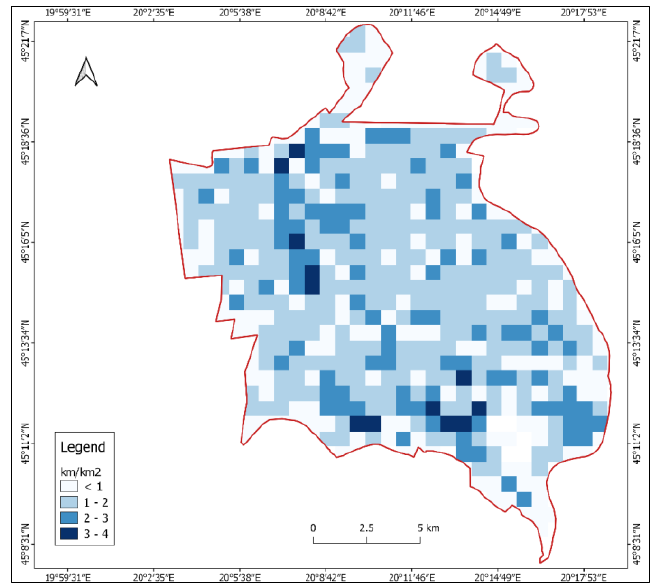
Figure 9. Drainage density (km/km 2 ) map of the study area.